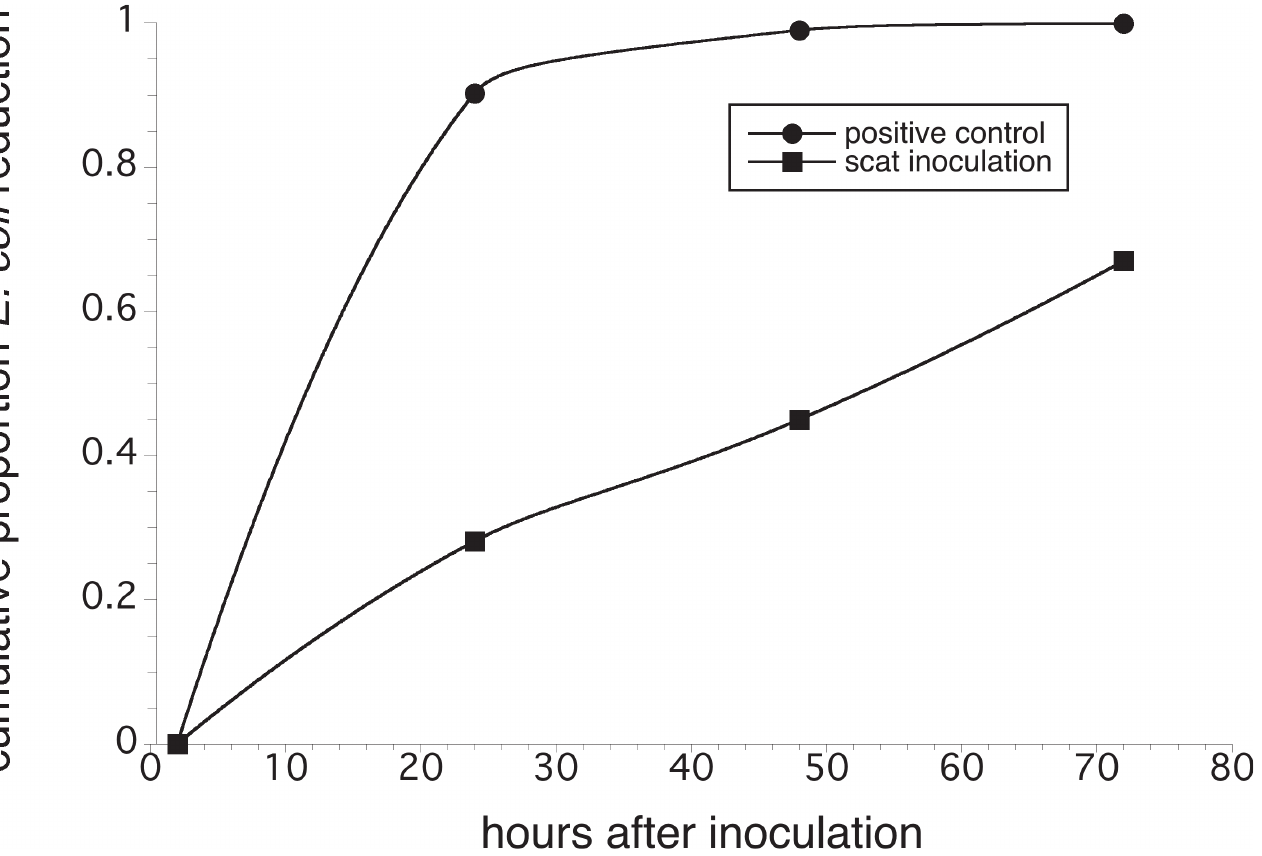
Fig 1. Field Experiment- Reduction in E . coli levels over time. Decay of E . coli O157:H7 mixture (strains ATCC 700728 and B6914) in field inoculation study. Reductions in E . coli levels on fruit are proportions of the inoculum at the 2 hr sampling period (positive control log CFU / g fruit = 6.498 ± 5.706; experimental treatment log CFU / g fruit = 2.963 ± 2.268). Decay rate at end of the first 24 h for the positive control is 0.910 and for the experimental treatment ( E . coli applied via deer scat) is 0.133.